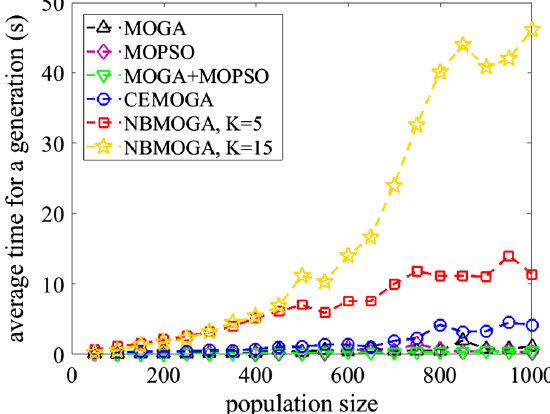
FIG. 4. The average running time for each generation of optimizing ZDT2 with different optimization methods and differ- ent population sizes. The average time is defined as the total optimizing time divided by the number of